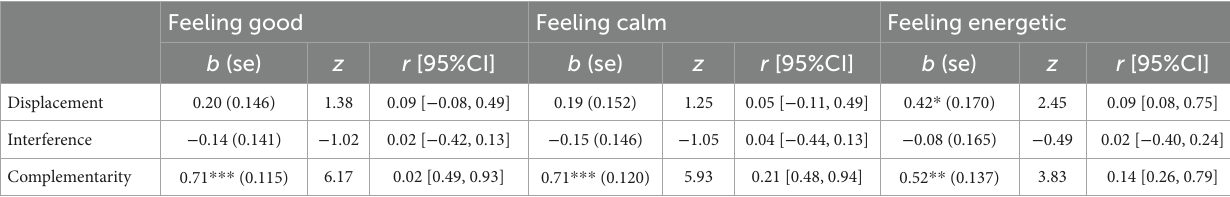
TABLE 3 Between-person associations between phone use indicators and feeling good, calm, and energetic.